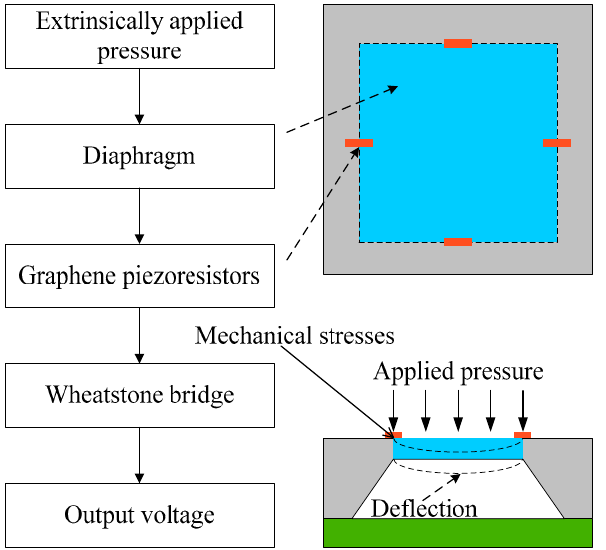
Figure 2. The primary working principle of a piezoresistive pressure sensor.